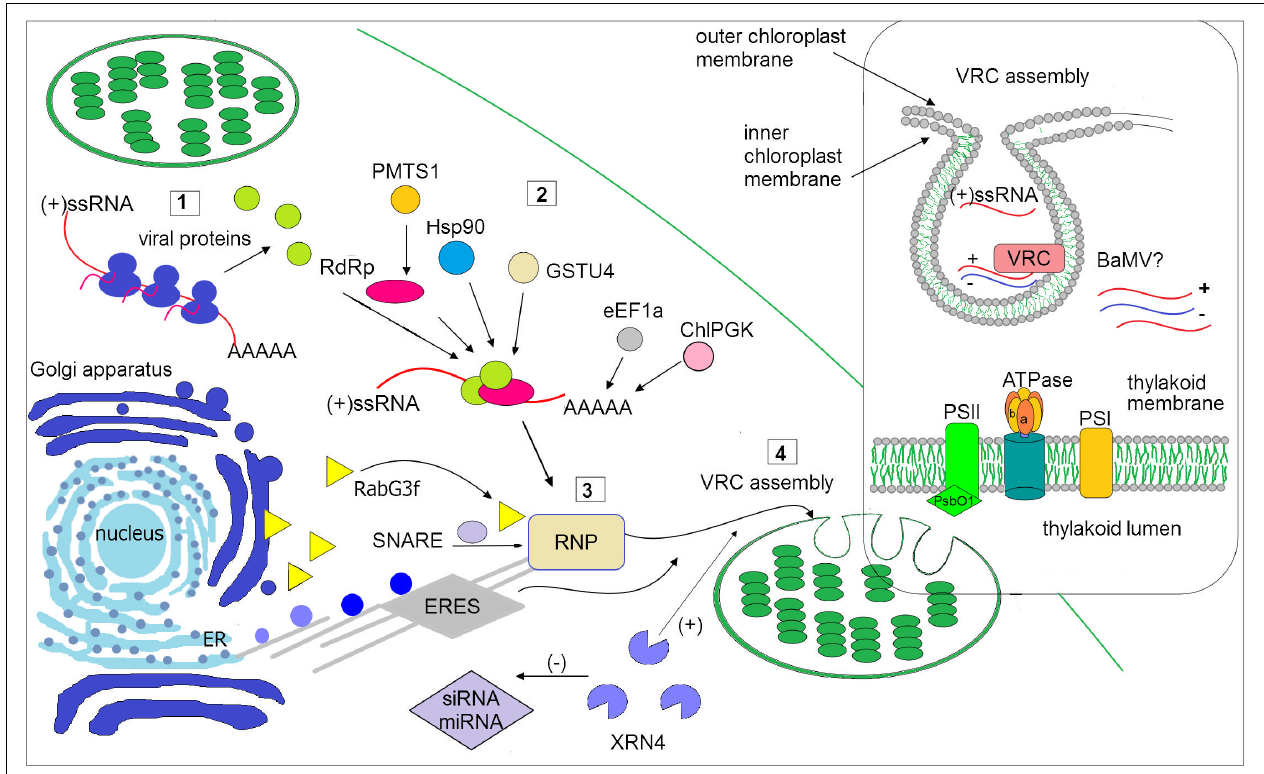
FIGURE 1 | Schematic illustration of selected host factors affecting viral RNA replication in chloroplasts. Synthesis of viral genomic RNA [(+)ssRNA] requires viral proteins: RdRp (pink circle) and auxiliary factors (green circles) that are translated at the early stage of infection (1). Then, virus recruits host factors (2) such as chaperone (Hsp90), methyltransferase (e.g., PMTS1), chloroplast phosphoglycerate kinase (chlPGK), which participate in viral replication complexes (VRC) targeting (in potexvirus). The 3 (cid:48) UTR of viral RNAs (in potexviruses, e.g., BaMV) interacts with several cellular proteins, including elongation factor 1a (eEF1a), glutathione S-transferase (GSTU4), exonuclease (XRN4). Exonuclease negatively regulates the activity of silencing pathway (miRNA/siRNA). Subsequently, the hijacked host factors, viral genomic RNA and viral proteins are trafficked to chloroplast membranes (3). The ribonucleoprotein complex (RNP) is transported from